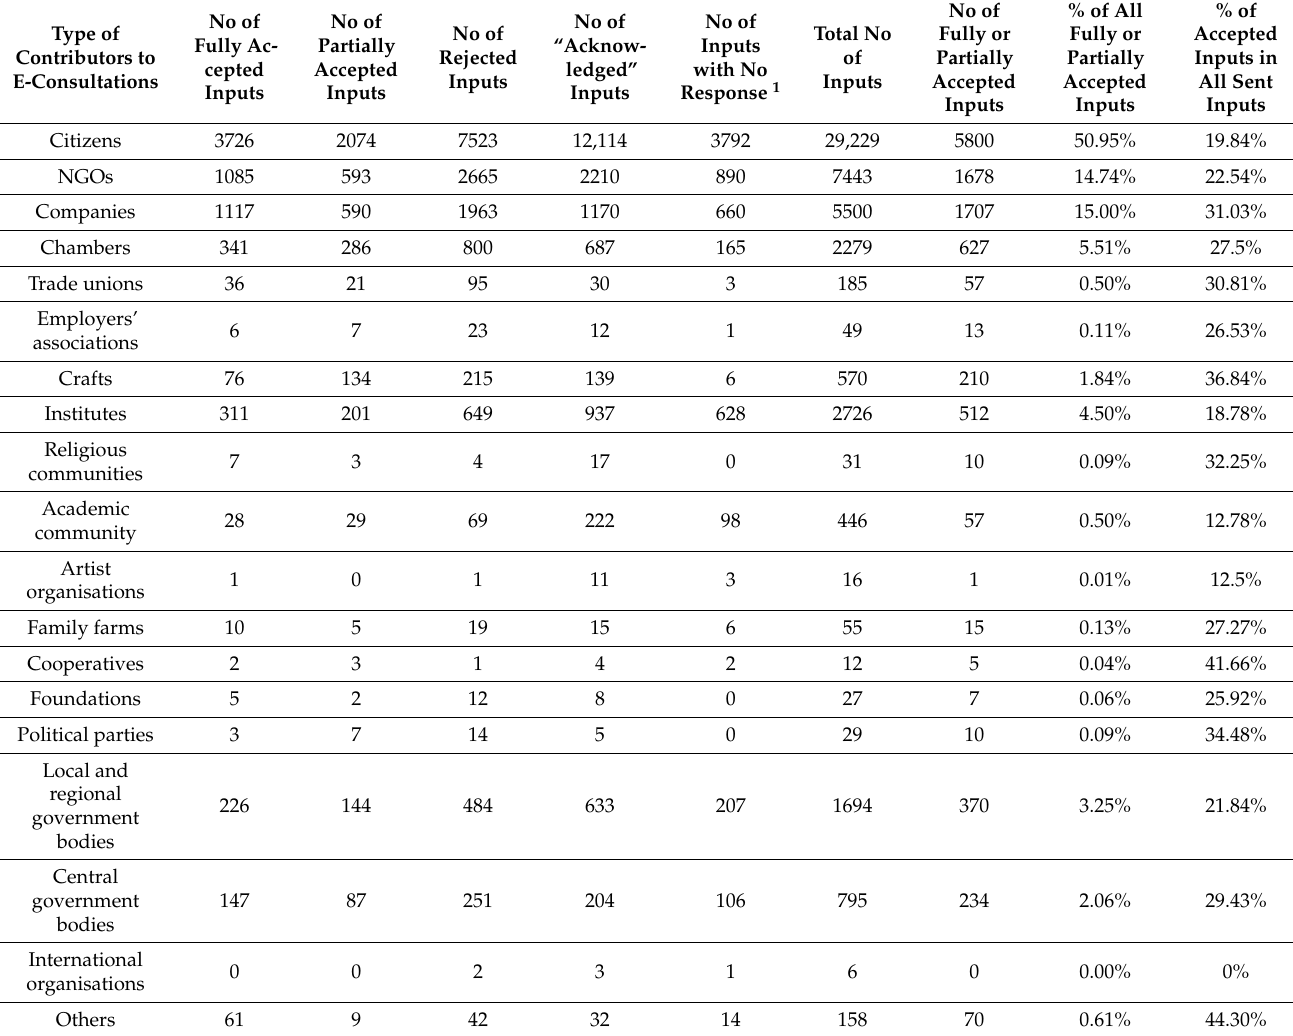
Table 5. Overview of responses of government bodies to policy inputs of various types of non-state actors via central e-consultations platform, from April 2015 until July